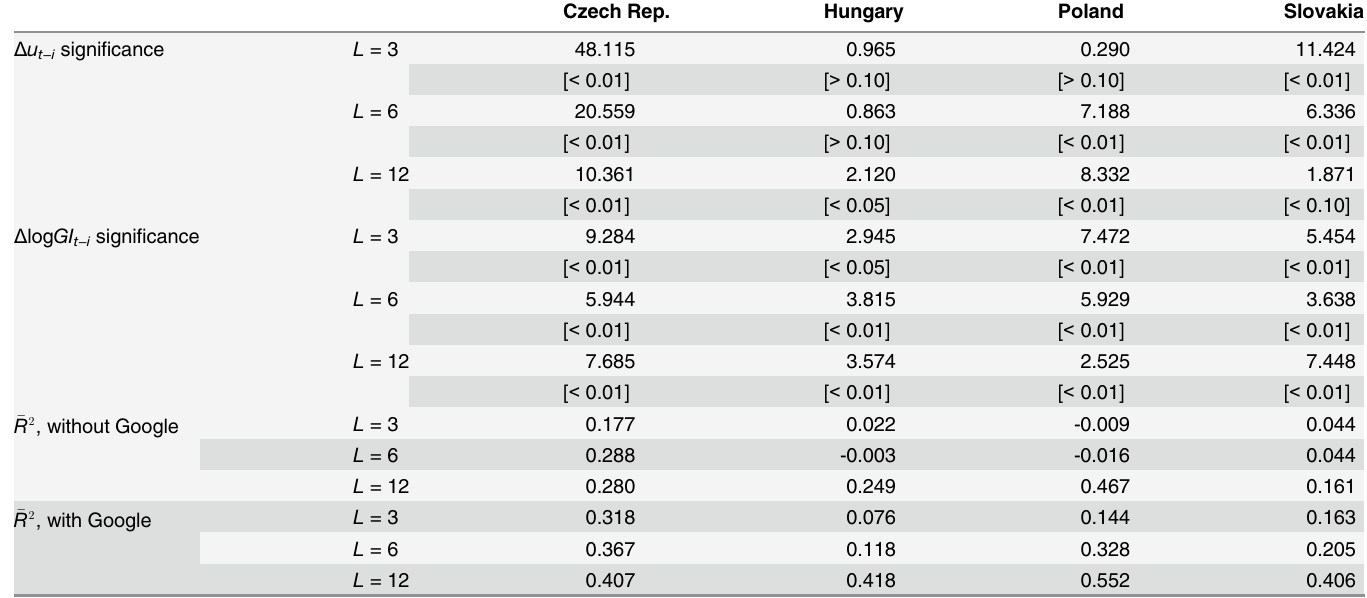
Table 3. Nowcasting summary (in-sample). The whole analyzed period 01/2004-12/2013 is covered here. Model in Eq 2 is used here with varying maxi- mum lag L . Joint significance of variables is a simple F -test based on heteroskedasticity and autocorrelation consistent (HAC) standard errors ( p -values are reported in the brackets). Adjusted coefficient of determination (cid:2) R 2 controls for the number of independent variables used in the model. Czech